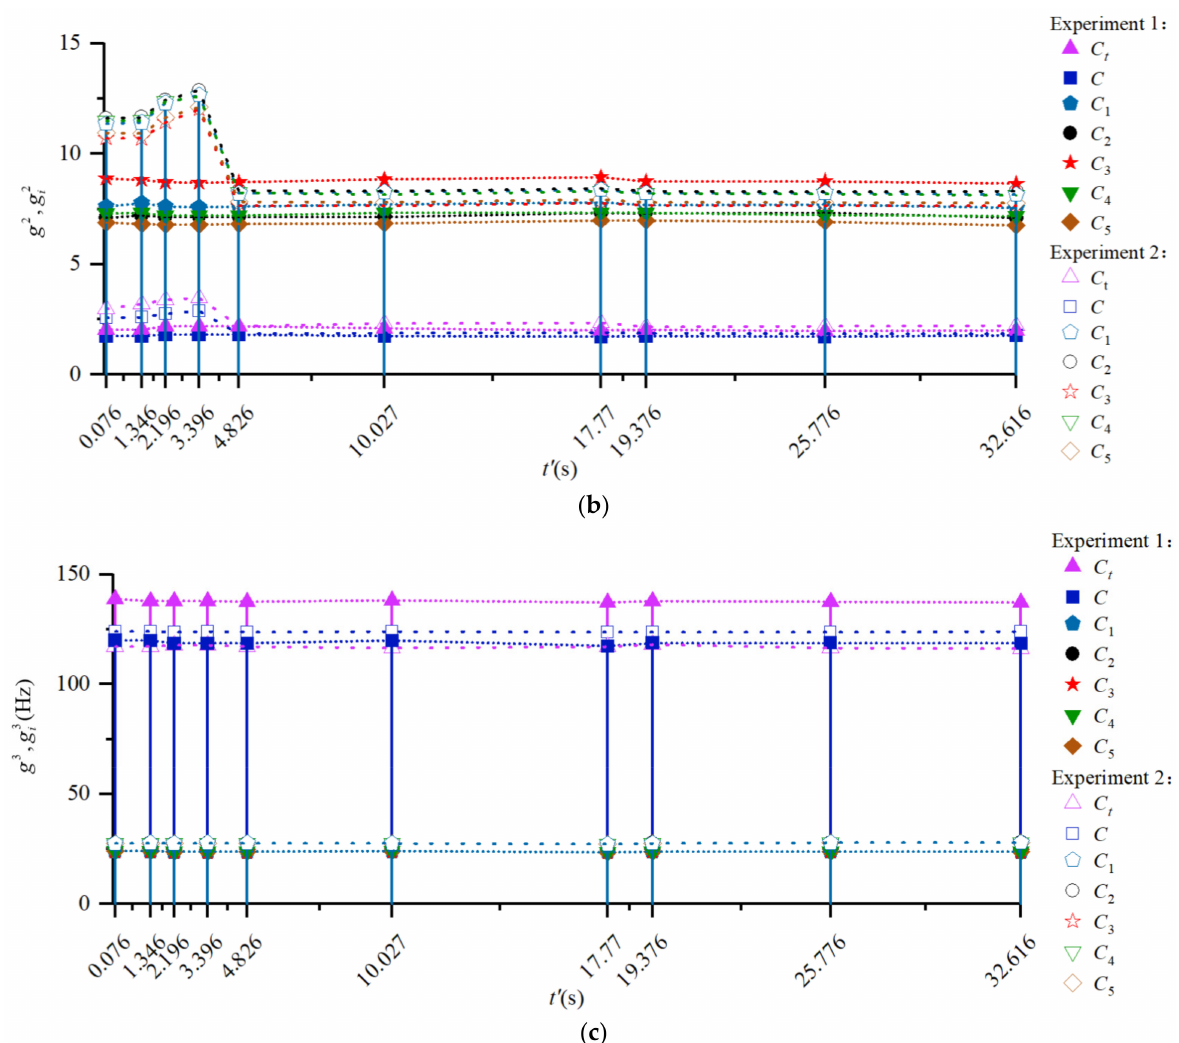
Figure 15. Response and verification of time–frequency of main cutting force energy consumption of the milling cutter, ( a ) root mean square, ( b ) kurtosis, ( c ) dominant